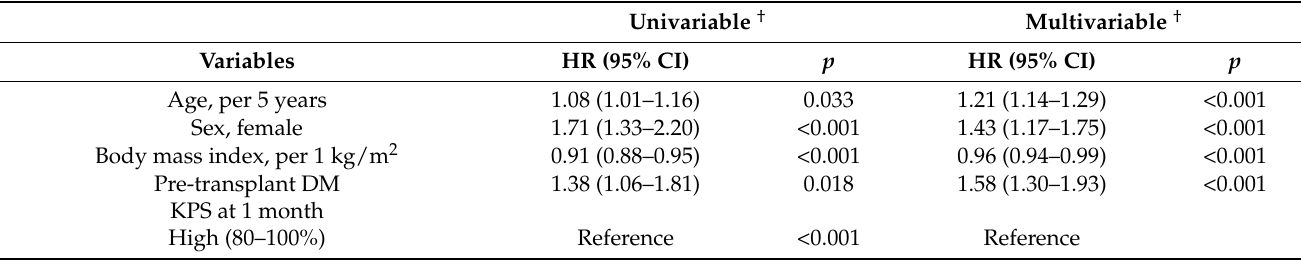
Table 2. Baseline risk factors for CKD after